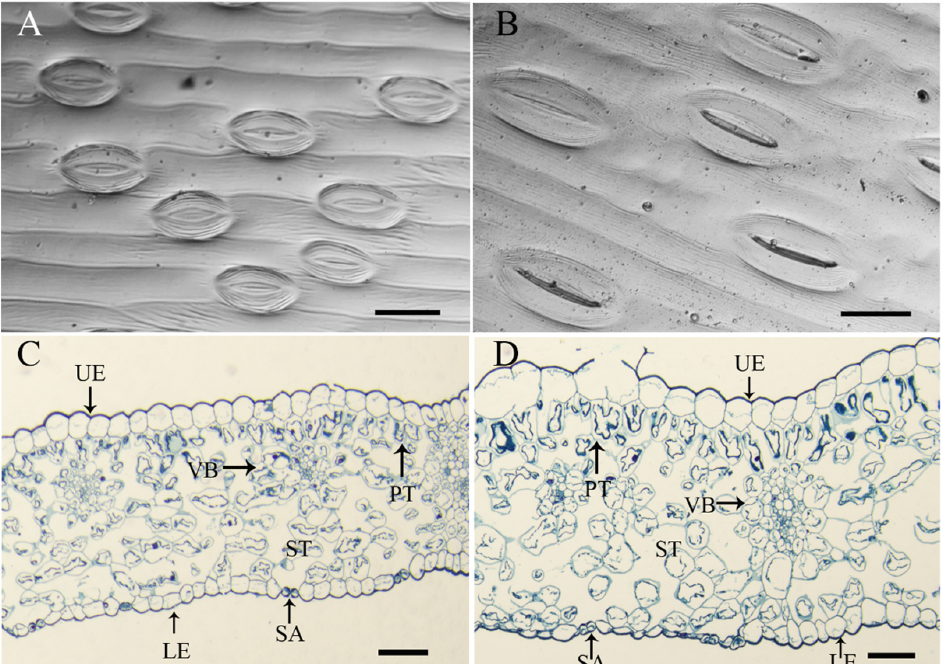
Figure 4. Stomata and anatomical structures of the leaves of allodiploid and allotetraploid lilies. Stomata within the leaf epidermis of allodiploids ( A ) and allotetraploids ( B ); bar = 50 μ m. Leaf anatomical structures of allodiploids ( C ) and allotetraploids ( D ). UE, upper epidermis; LE, lower epidermis; PT, palisade tissue; ST, spongy tissue; VB, vascular bundle; SA, stoma; bar =100 μ m. Table 1. The stomatal size and density of allodiploid and allotetraploid Lilium FA hybrids.